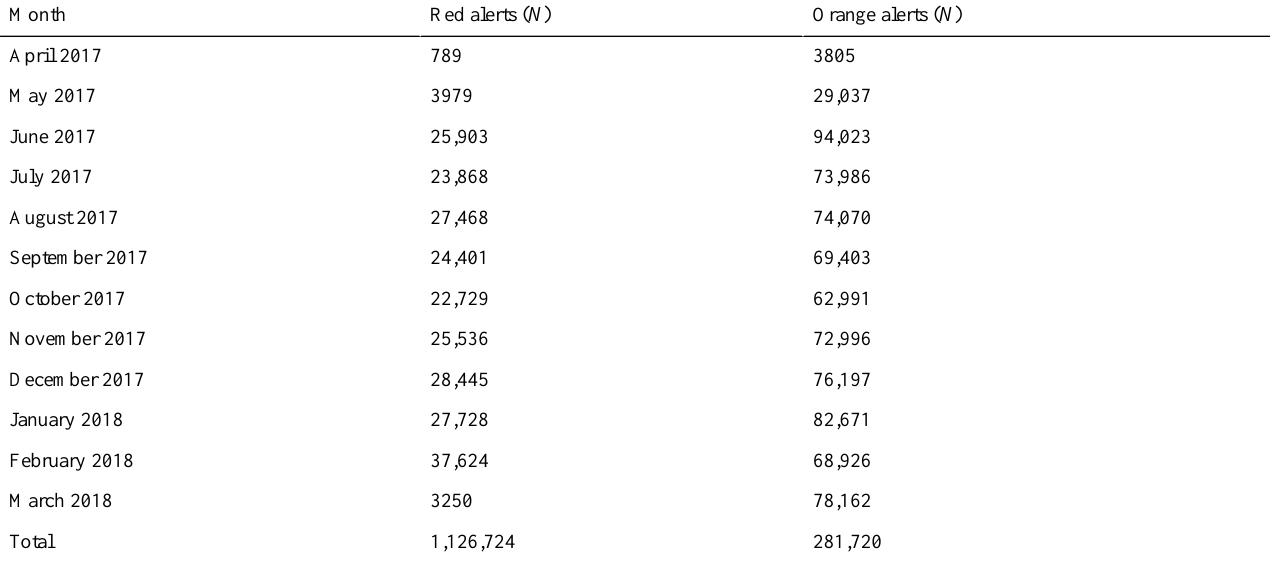
Table 5. Number of red and orange alerts presented by the MDSS each month.